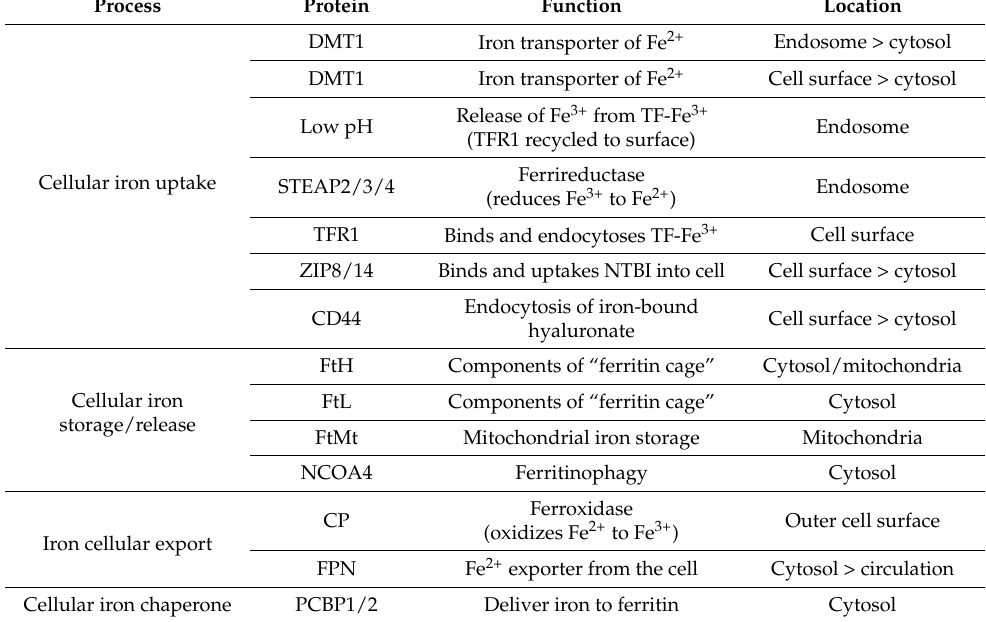
Table 1. The main proteins involved in the intracellular iron metabolism. The proteins have been divided according to the iron-related process they are involved in. Their specific function and cellular localization were subsequently reported in the last two